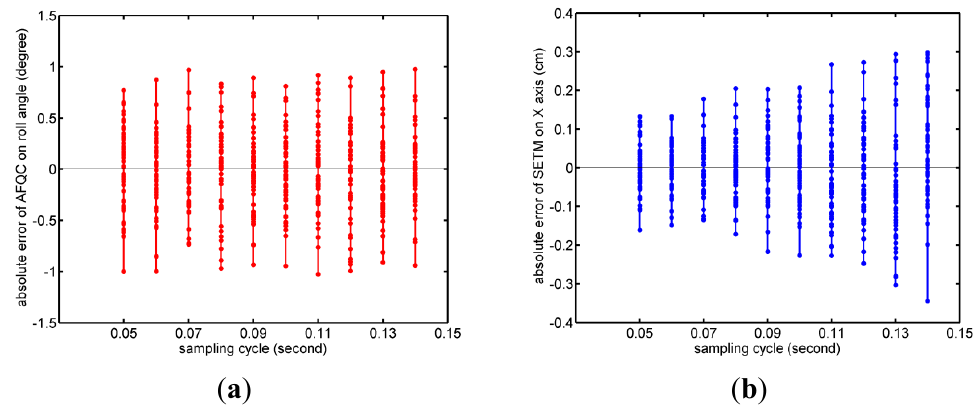
Figure 15. Absolute error of tracking for different sampling cycles. ( a ) RMSE of AFQC on roll angle; ( b ) RMSE of SEMT on X